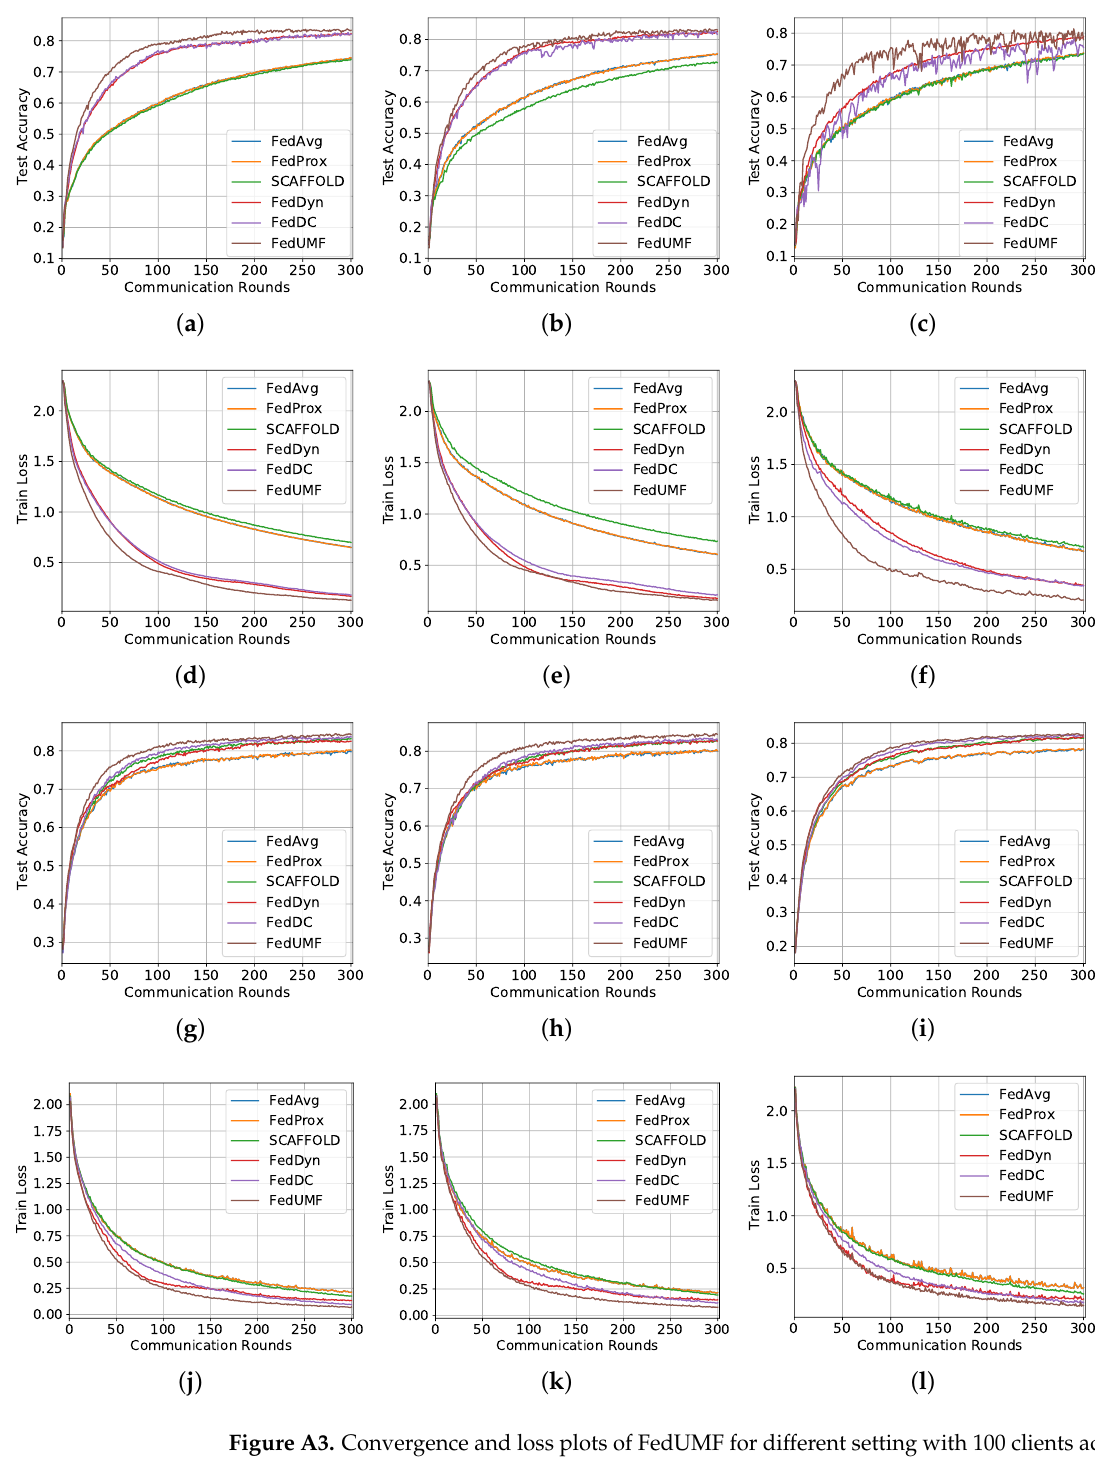
Figure A3. Convergence and loss plots of FedUMF for different setting with 100 clients adopting 15% and 65% client participating settings on CIFAR. ( a ) Test Acc. IID 15%. ( b ) Test Acc. unbalance 15%. ( c ) Test Acc. Drichlet 0.6 15%. ( d ) Train Loss. IID 15%. ( e ) Train Loss. unbalance 15%. ( f ) Train Loss. Drichlet 0.6 15%. ( g ) Test Acc. IID 65%. ( h ) Test Acc. unbalance 65%. ( i ) Test Acc. Drichlet 0.6 65%. ( j ) Train Loss. IID 65%. ( k ) Train Loss. unbalance 65%. ( l ) Train Loss. Drichlet 0.6